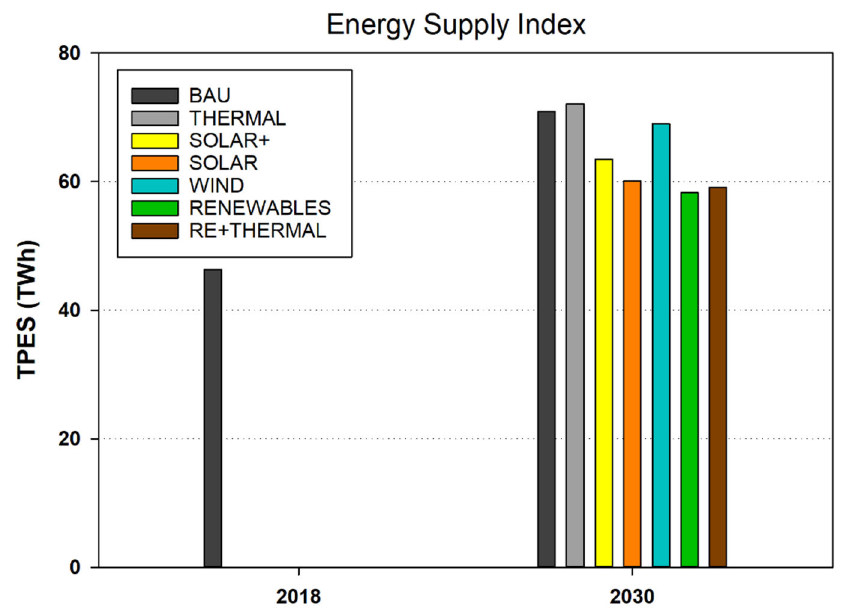
Figure 9. Total primary energy supply as energy supply index for base and forecast years.